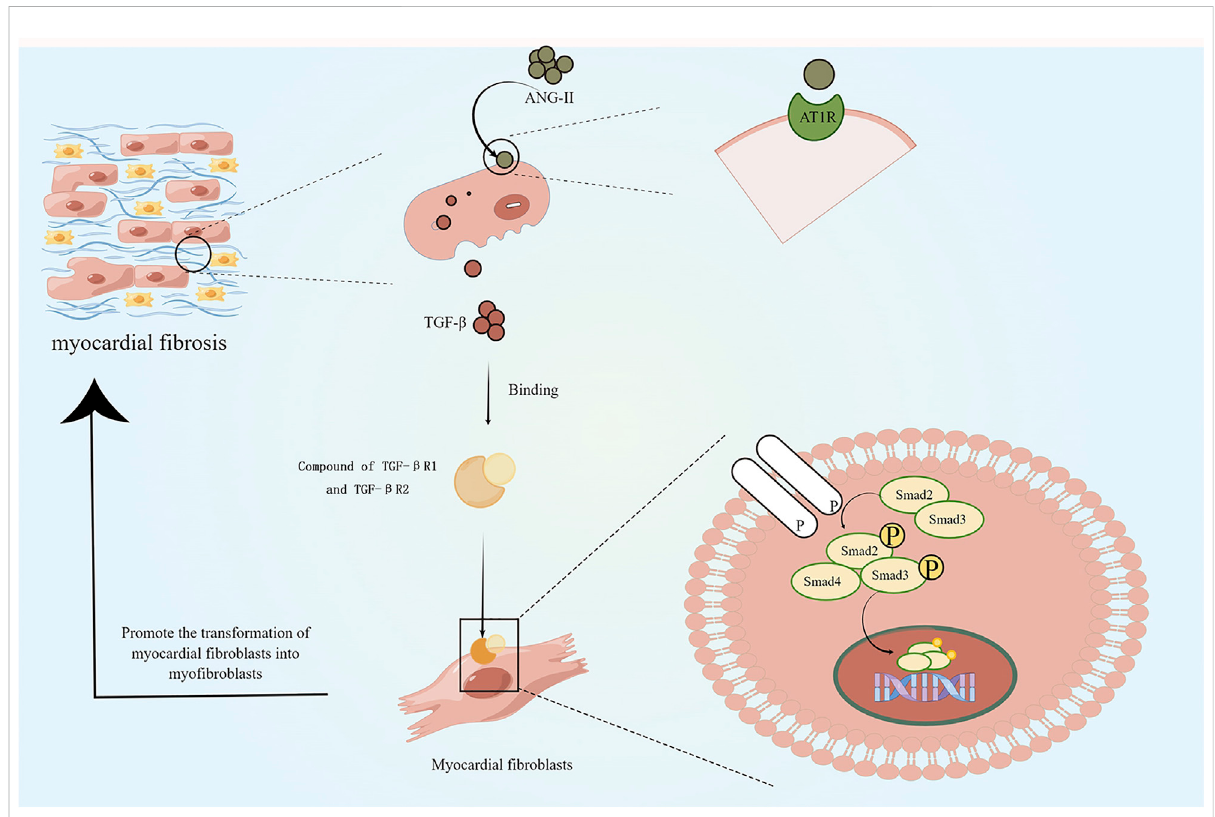
FIGURE 2 Effects ofslow activation of RAAS on myocardial fi brosis: slow activation of RAAS leadsto release of angiotensin II, which stimulates therelease of transforming growth factor- β (TGF- β ) via the AT1R pathway. TGF- β R1 forms a complex with TGF- β R2 and stimulates downward phosphorylation of the intracellular effector protein Smad2/3, which forms with Smad4 complex and moves to the nucleus. This process contributes to the differentiation of cardiac fi broblasts into myo fi broblasts and increases collagen deposition. (By